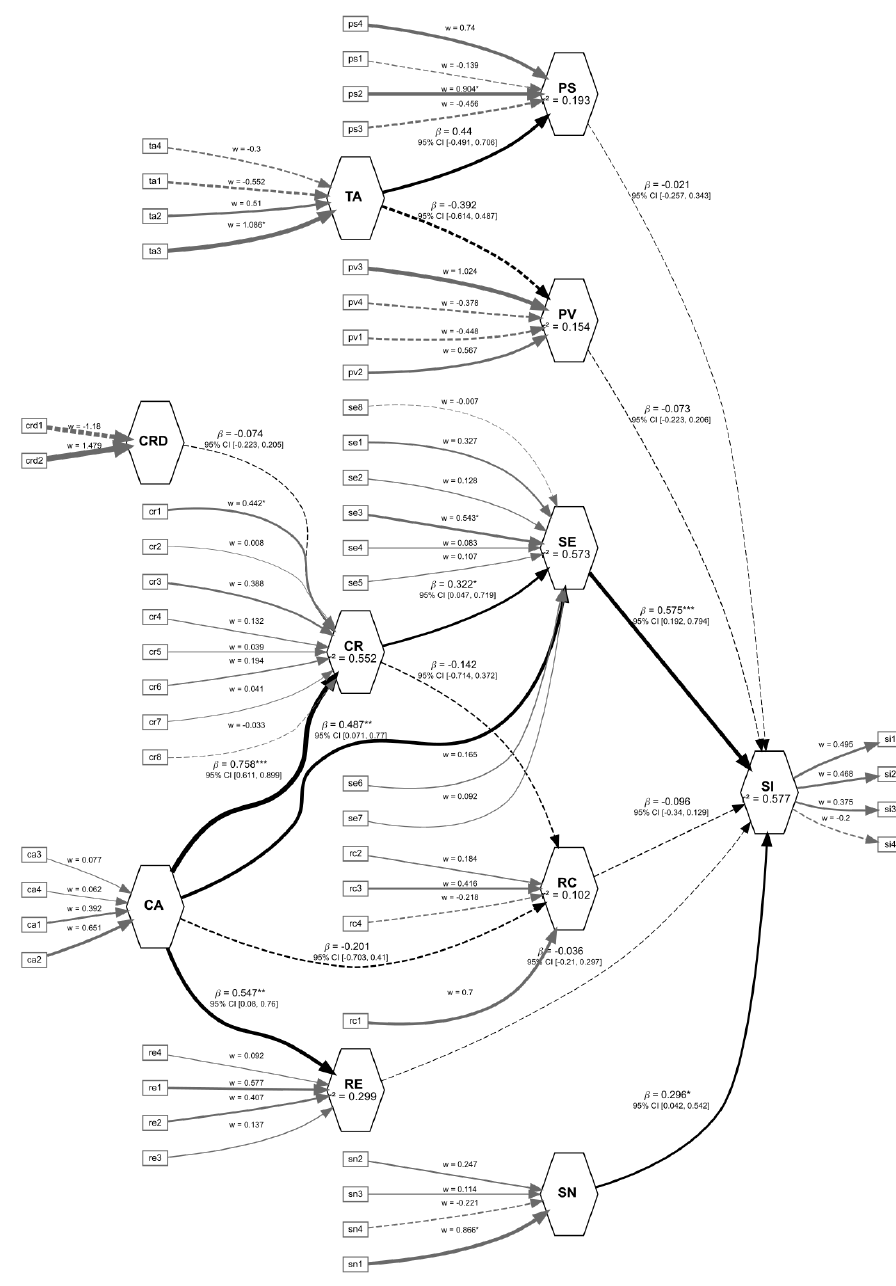
Figure A1. A complete overview of the (bootstrapped) PLS-SEM model, including all indicator weights. ∗ p < 0.05; ∗∗ p < 0.01; ∗∗∗ p <